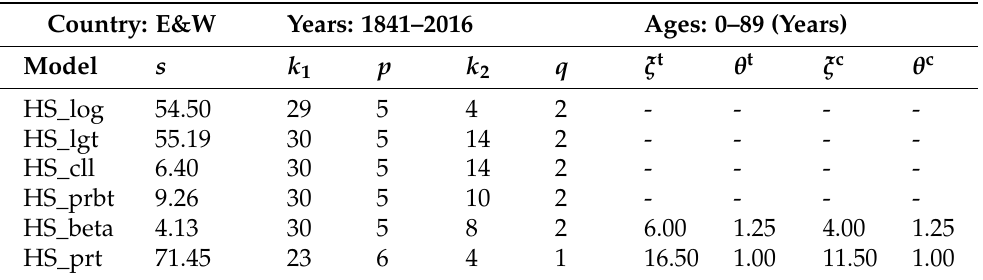
Table 2. Optimum parameters for each HS model extension structure for the E&W dataset. Country: E&W